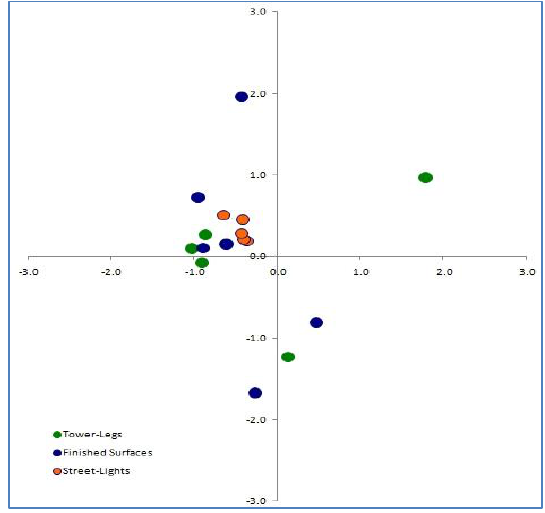
Figure 16. Scatterplot for features